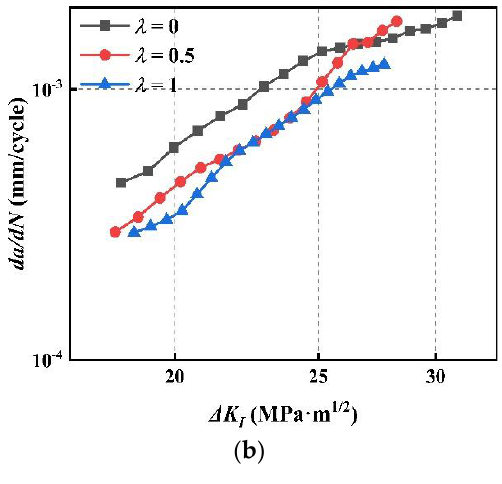
Figure 12. Where β = 60 ◦ , the relationship between FCGR and ∆ K I under different stress ratios ( a ) R = 0 ( b ) R = 0.1 ( c ) R = 0.3.